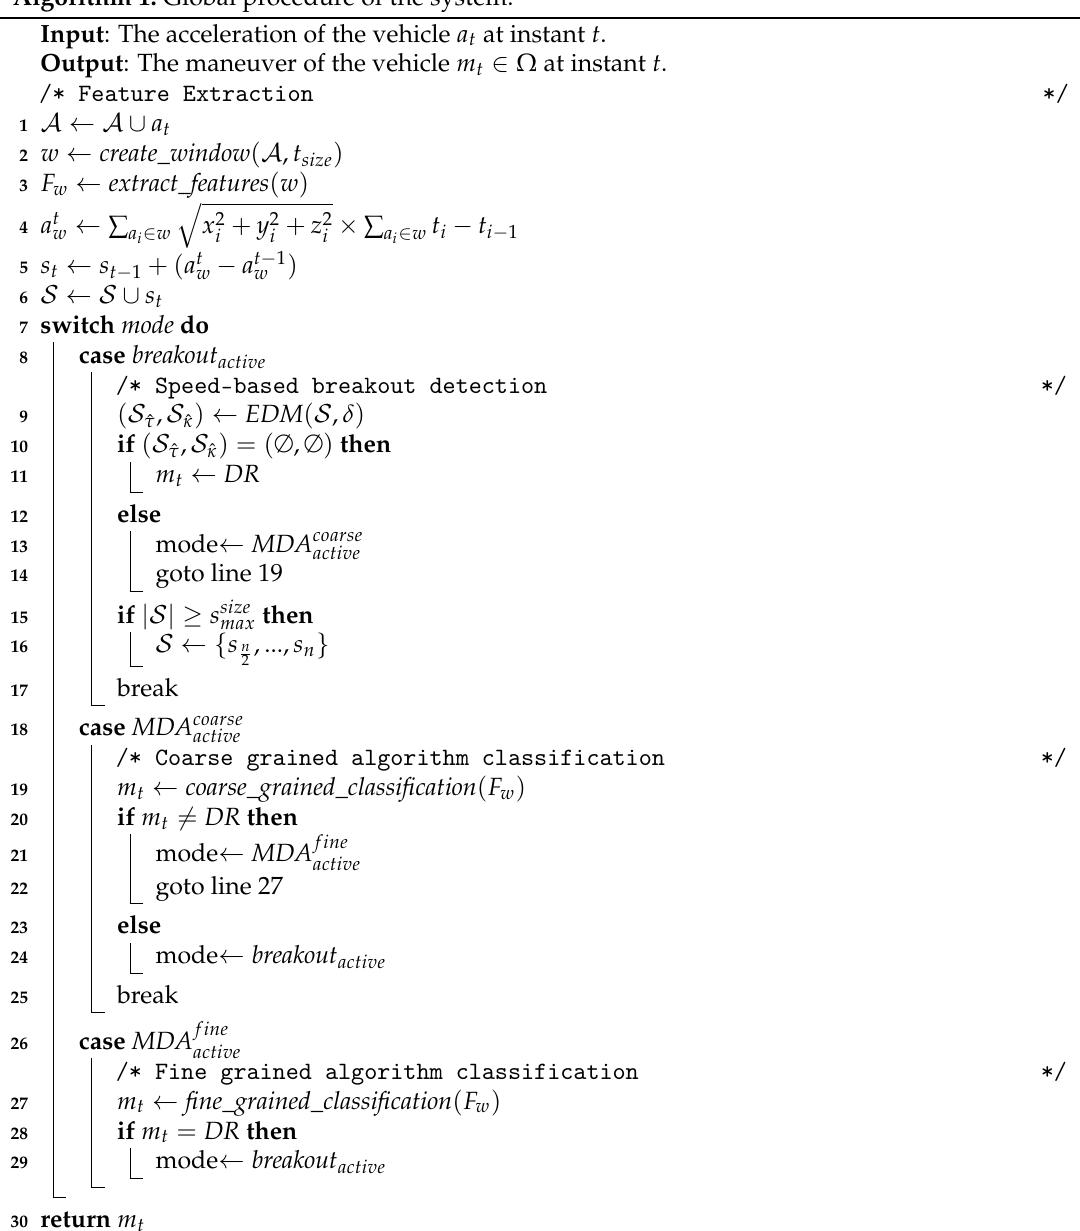
Algorithm 1: Global procedure of the